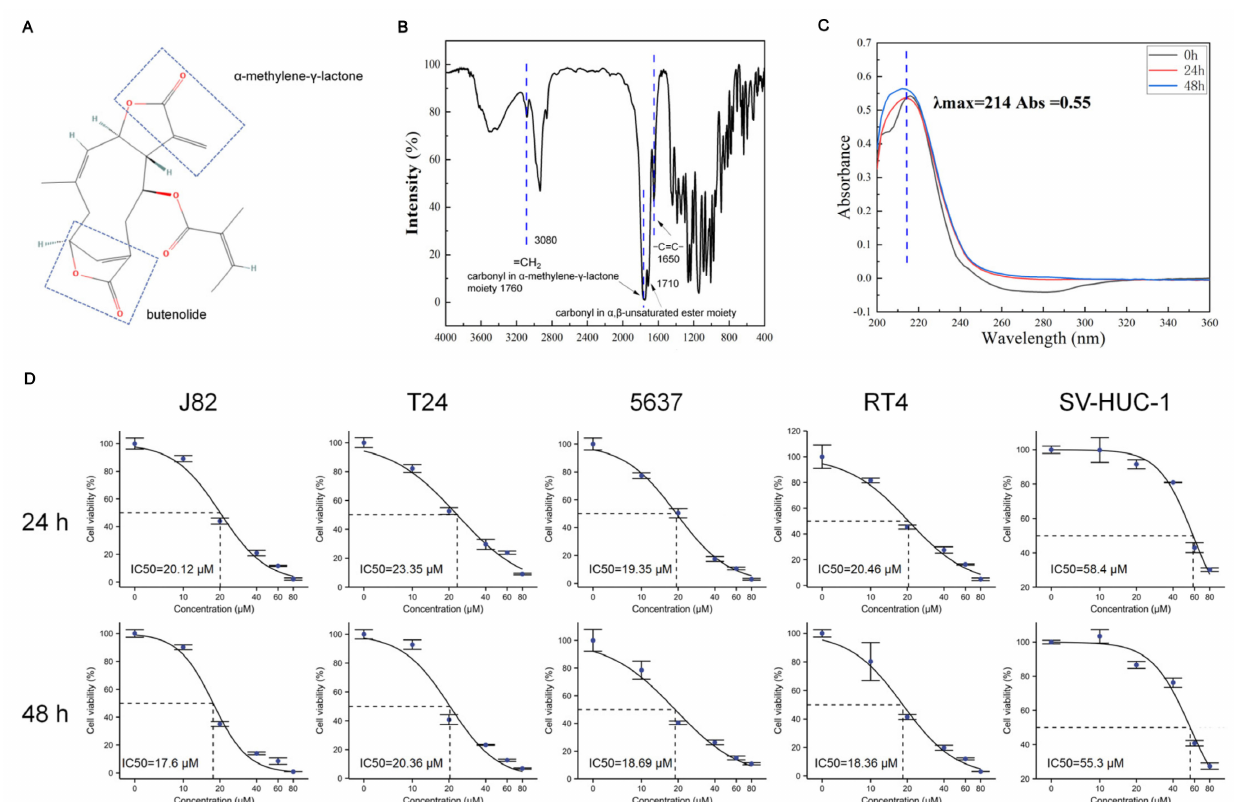
Figure 1. Chemical structure, stability, and efficacy of scabertopin against bladder cancer cells. ( A ). Chemical structure scabertopin. The two boxes show the structure of the molecule with the drug activity of α -methylene- γ -lactone and butenolide. ( B ). Infrared spectrum of scabertopin. The stretching vibration of =CH 2 exists at 3080 cm − 1 , and the carbonyl stretching vibration of α -methylene- γ -lactone structure exists at 1760 cm − 1 . The peak at 1710 cm − 1 is the carbonyl stretching vibration of another non-lactone α , β -unsaturated ester, and the C=C stretching vibration exists at 1650 cm − 1 . ( C ). The UV absorption peak of scabertopin in the DMEM medium at 0, 24, and 48 h. ( D ). 24 and 48 h IC50 of bladder cancer cell lines (J82, T24, 5637, and RT4) and human ureteral epithelial immortalized cells (SV-HUC-1) (n =